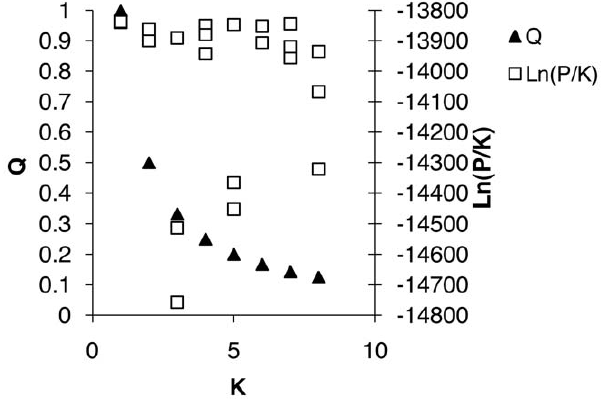
Figure 3. Likelihood (Ln[Pr(X/K)]) and mean maximum Q (proportion of ancestry for each individual assigned to a cluster) plots for STRUCTURE analysis using three runs each for K=1 to